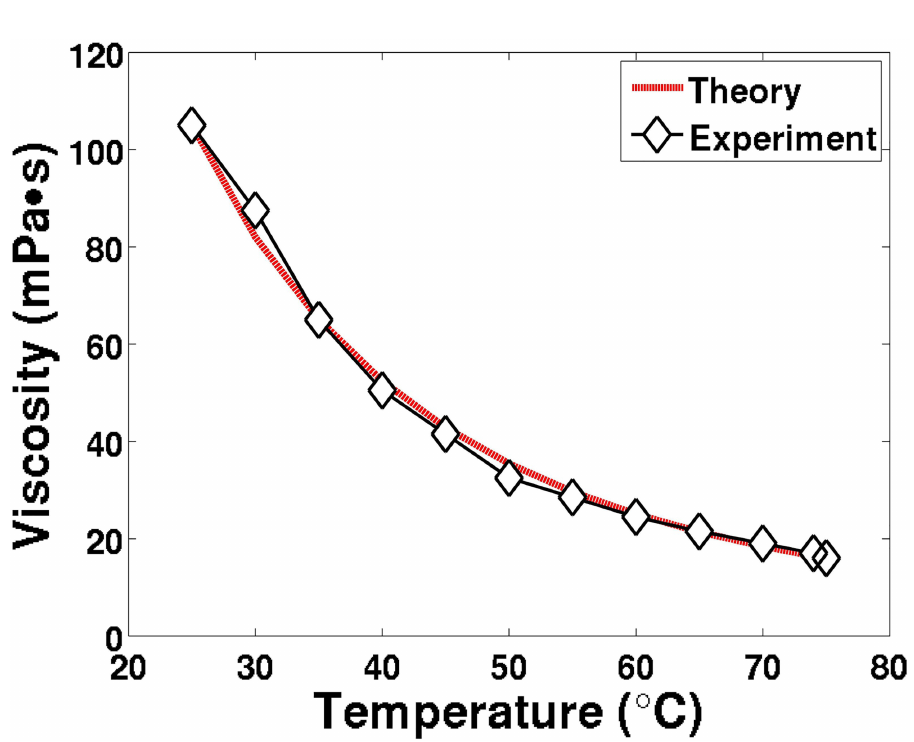
Fig 8. Mineral oil dynamic viscosity